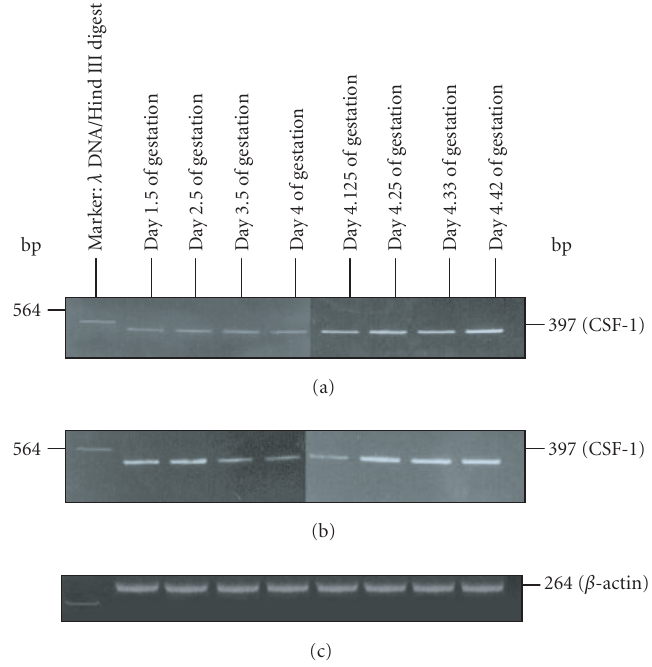
Figure 4: Detection of CSF-1 mRNA transcripts in the mouse uterine horns collected from (a) LPS-treated animals and (b) control animals at the di ff erent stages of preimplantation period of pregnancy by RT-PCR. Pannel (c) shows a representative picture showing uniform expression of β -actin used as an internal